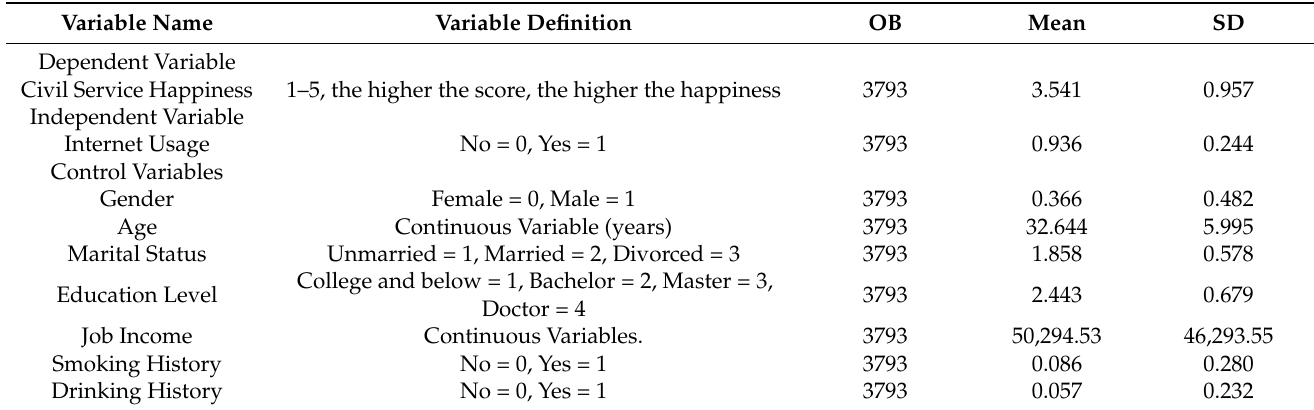
Table 1. Descriptive statistics of the variables.